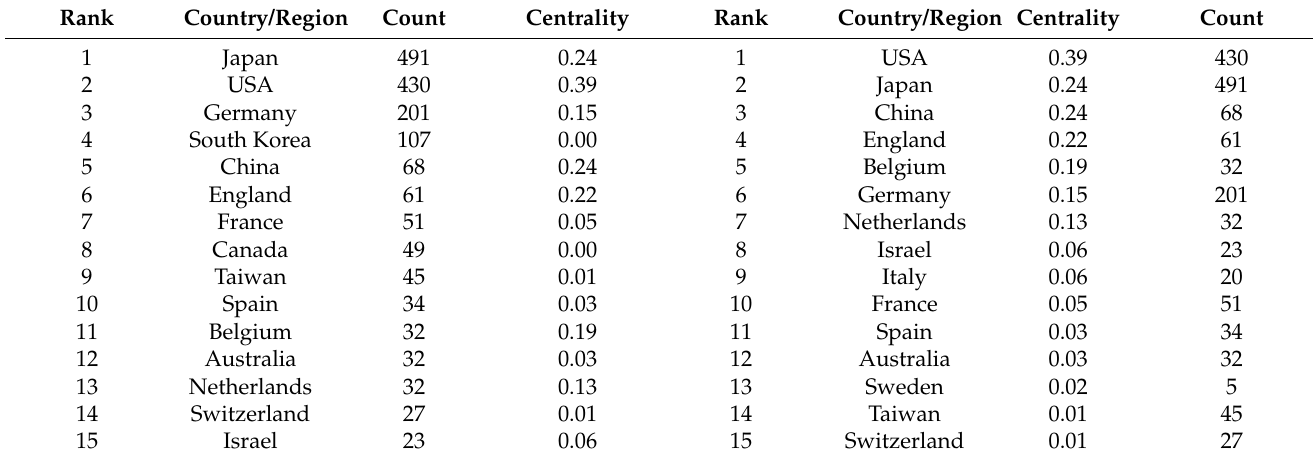
Table 1. Top 15 countries/regions based on publications and centrality.